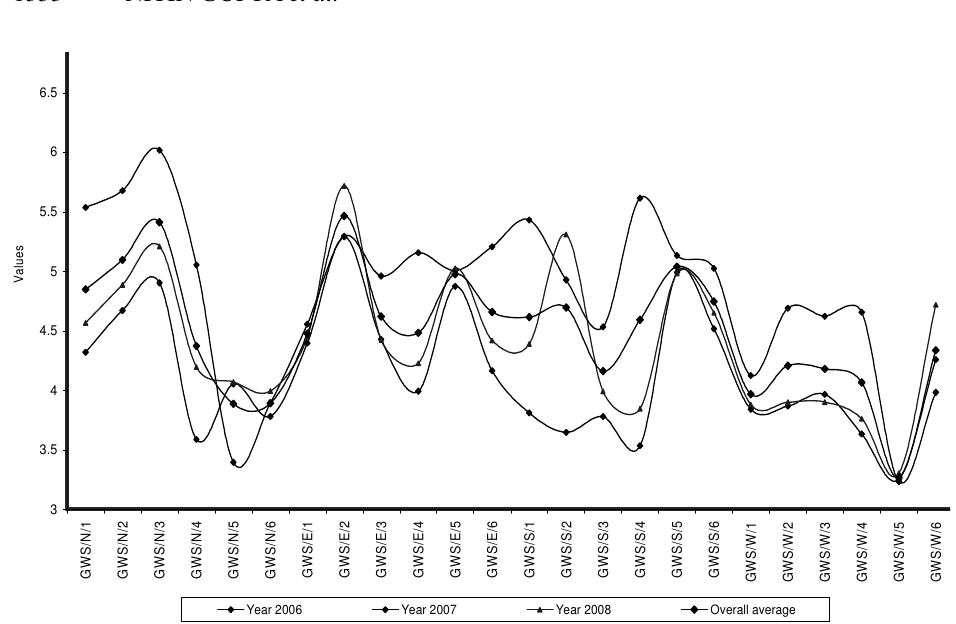
Figure 2. Calculated values of Ryznar saturation index